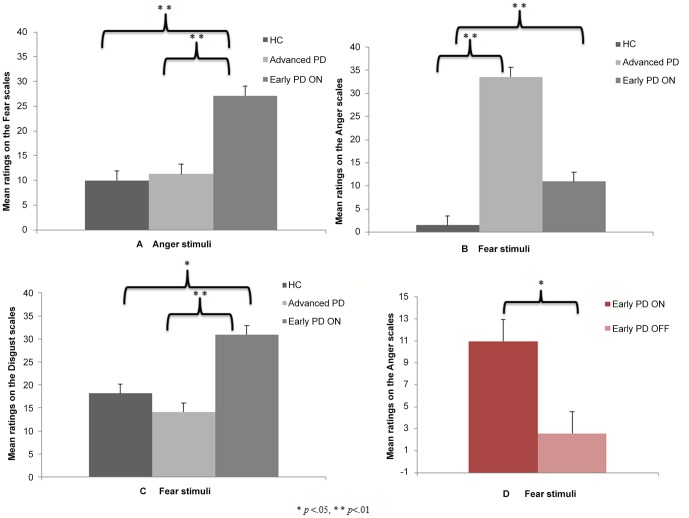
Mean ratings (and standard errors) (A) across all three groups (early PD ON, advanced PD and HC) on the Fear scale when the stimulus was anger, (B) across all three groups (early PD ON, advanced PD and HC) on the Anger scale when the stimulus was fear, (C) across all three groups (early PD ON, advanced PD and HC) on the Disgust scale when the stimulus was fear, and (D) provided by early PD patients in the ON versus OFF conditions on the Anger scale when the stimulus was fear.